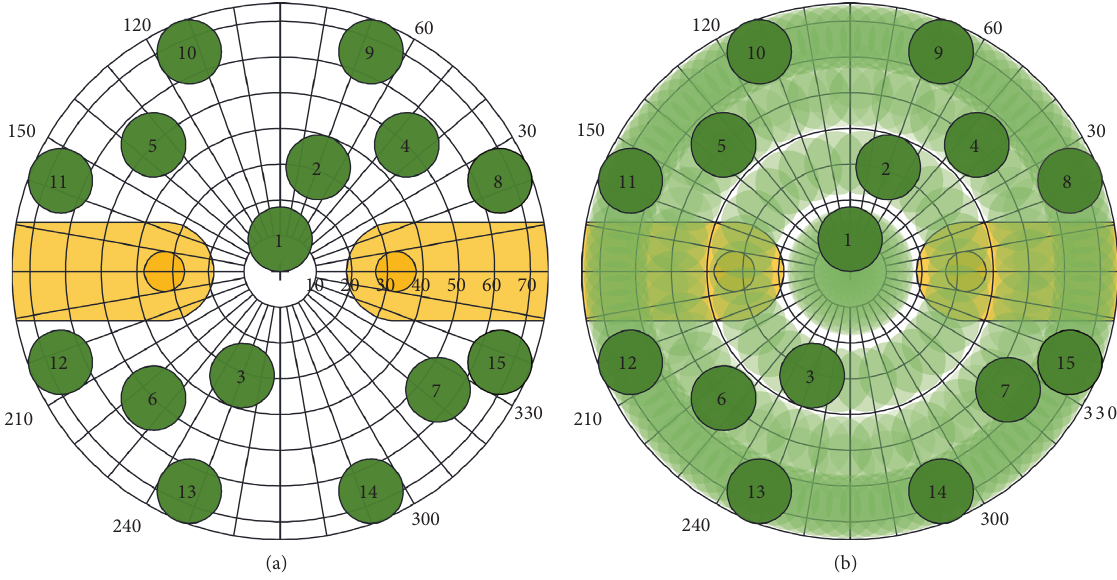
Figure 11: Impact points of buttons depending on the operating conditions: (a) button arrangement and (b) effect during drilling.